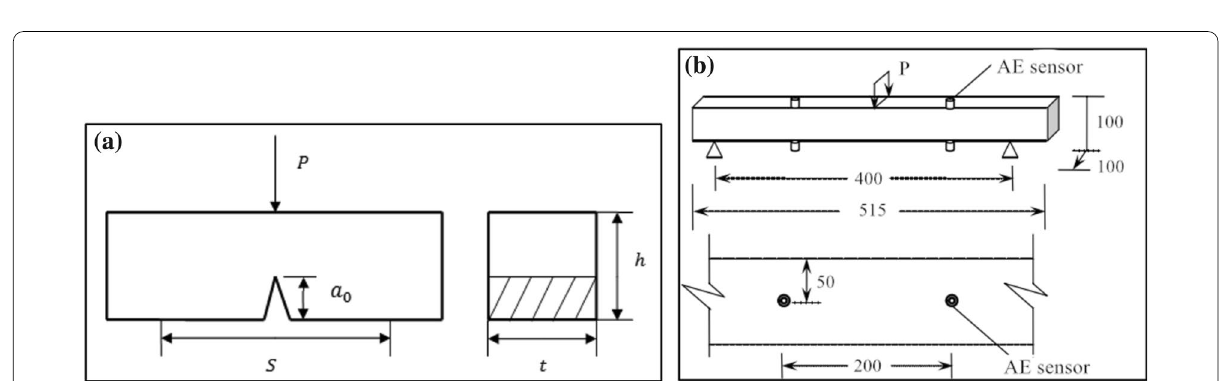
Fig. 5 Schematic diagram of the test piece size and test arrangement: a dimensions of test specimen; b acoustic emission sensor layout.